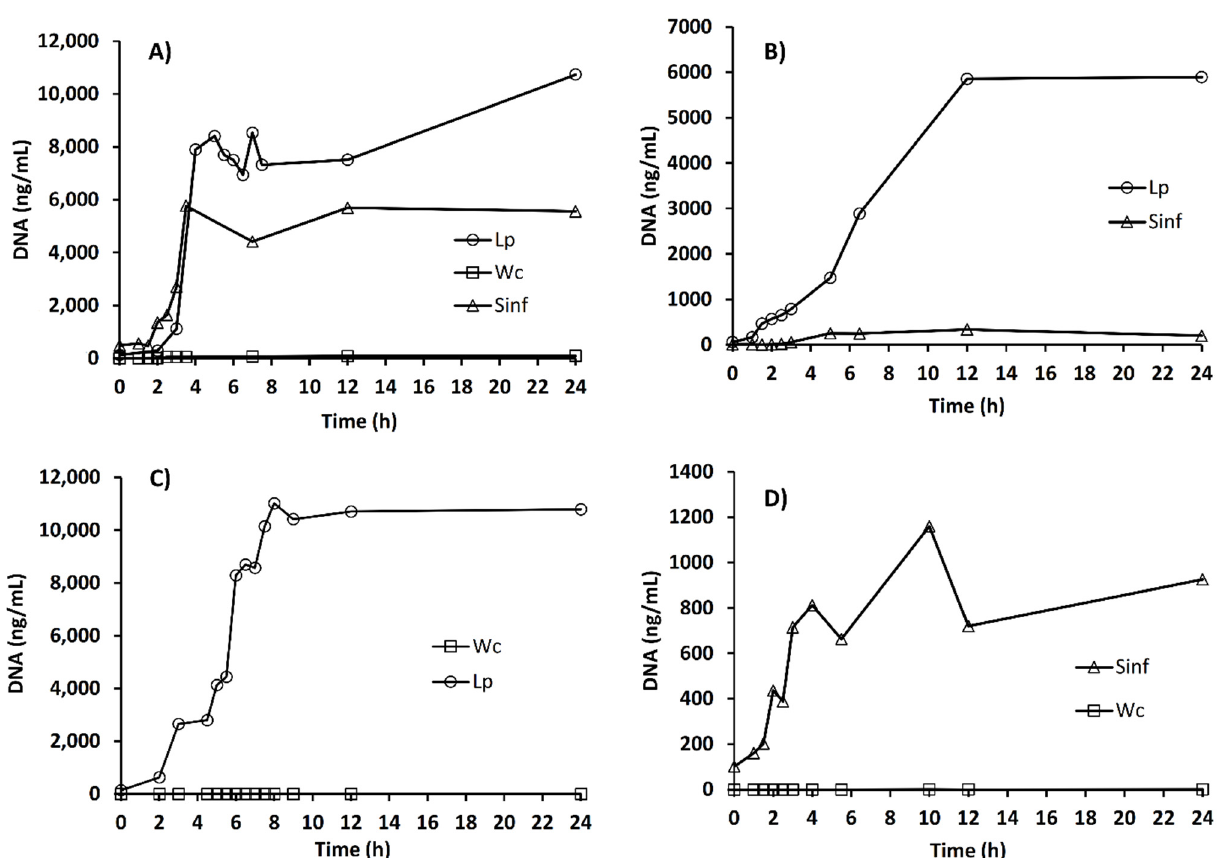
Figure 2. Growth, measured by DNA (Quantitative PCR) of L. plantarum A6 (new name Lactiplantibacillus plantarum ), (Lp), Sii. 25,124 (Sinf) and W. confusa 17 (Wc) DNA during the fermentation. ( A ) Fermentation performed by pure cultures; ( B ) fermentation performed by L. plantarum A6 and Sii -25124; ( C ) fermentation performed by L. plantarum A6 and W. confusa 17; ( D ) fermentation performed by Sii 25,124 and W. confusa 17.